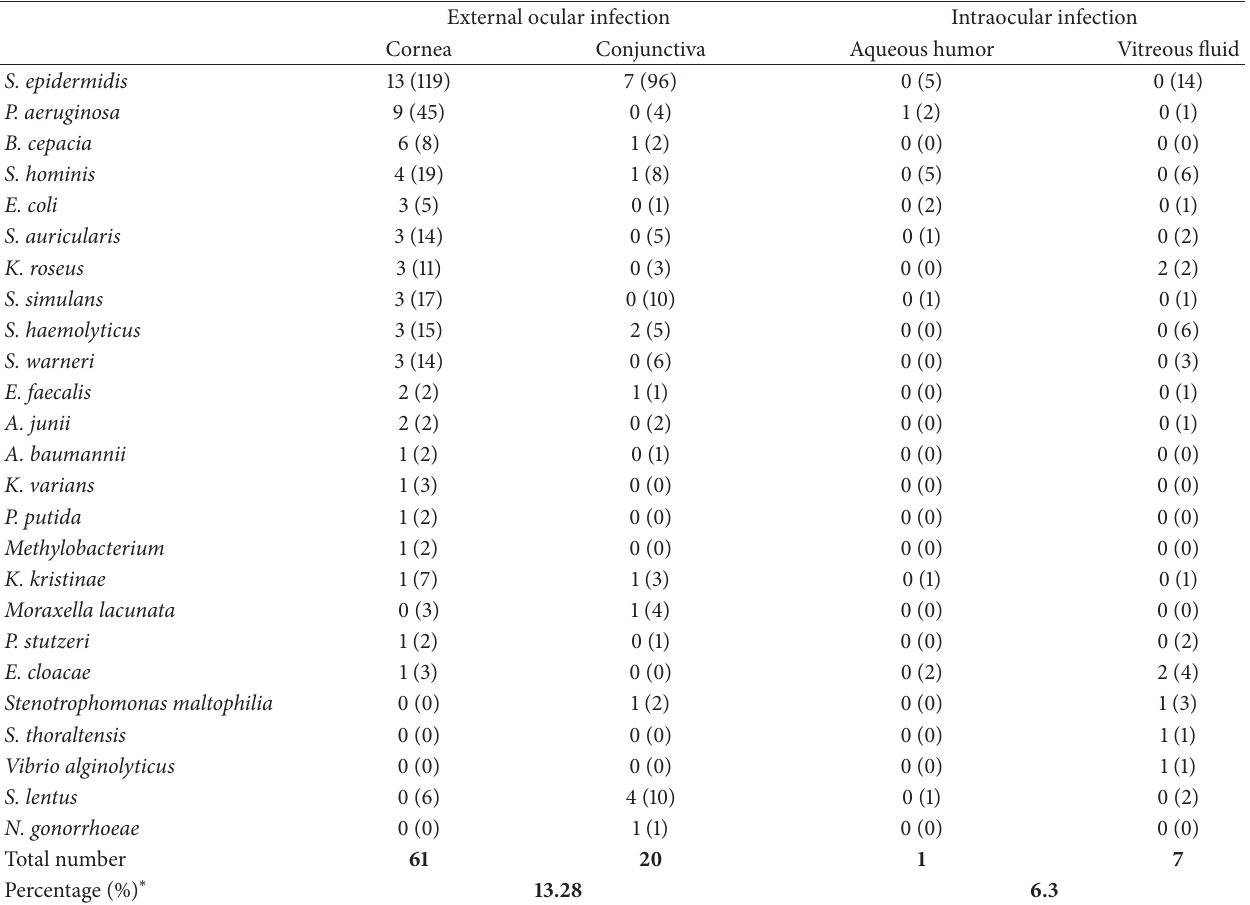
Table 2: Comparison of MDR bacteria between external and intraocular infections.